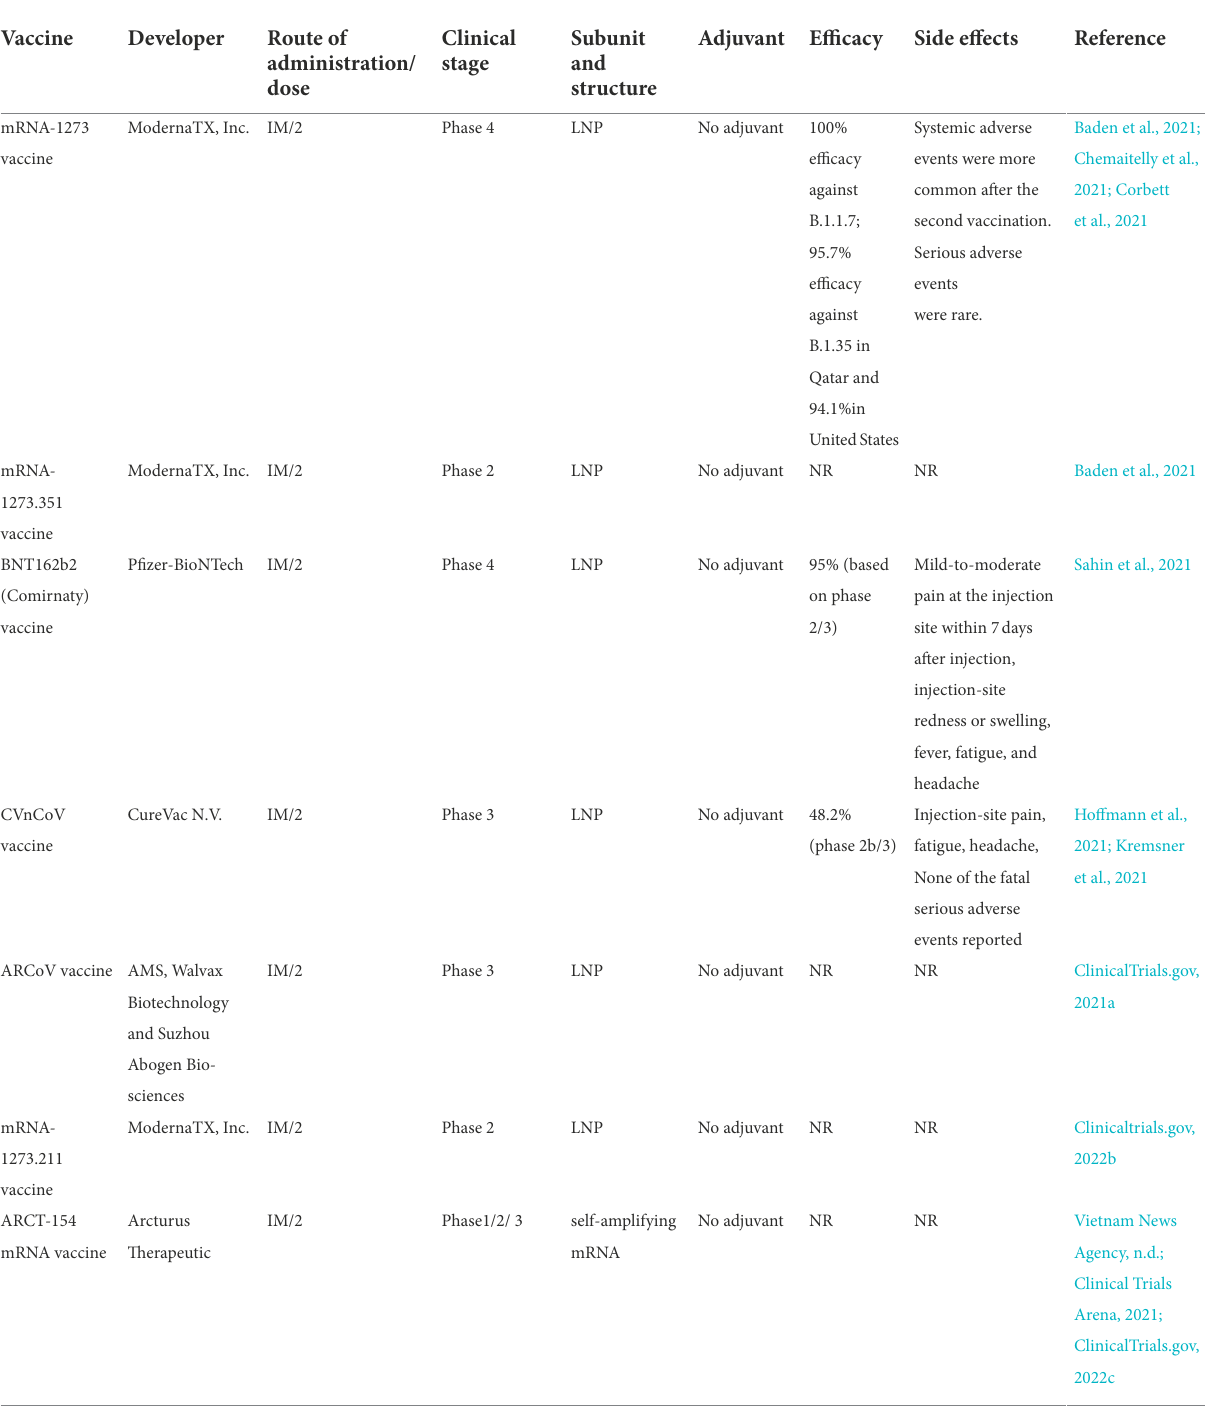
TABLE 2 Characteristics of COVID-19 RNA vaccines. Vaccine